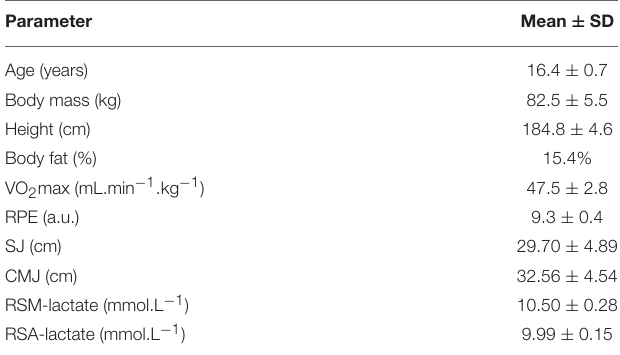
TABLE 1 | Anthropometric characteristics, jumping performance and aerobic capacity of